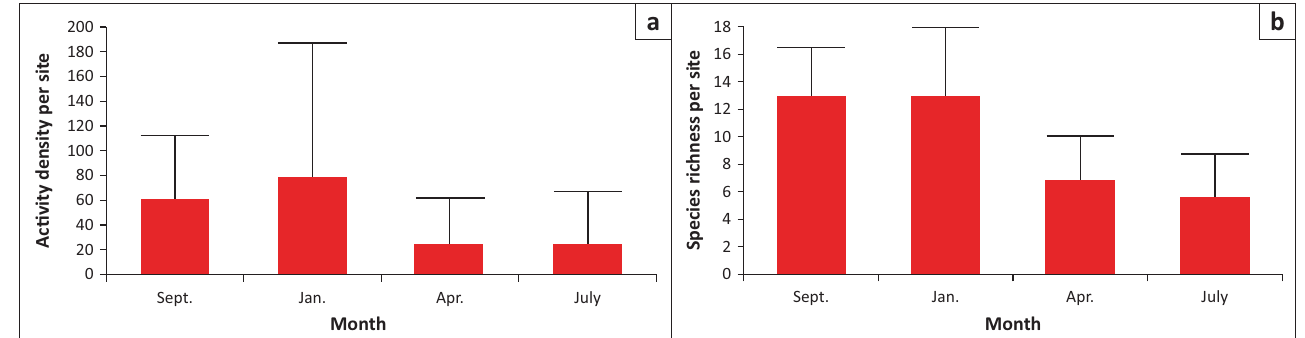
020 Sept. Jan. Apr. FIGURE 3: Seasonal variation in mean ± SD of (a) activity densities and (b) species richness of ground-dwelling spiders across 16 sites (eight habitats) sampled in the Amanzi Private Game Reserve.